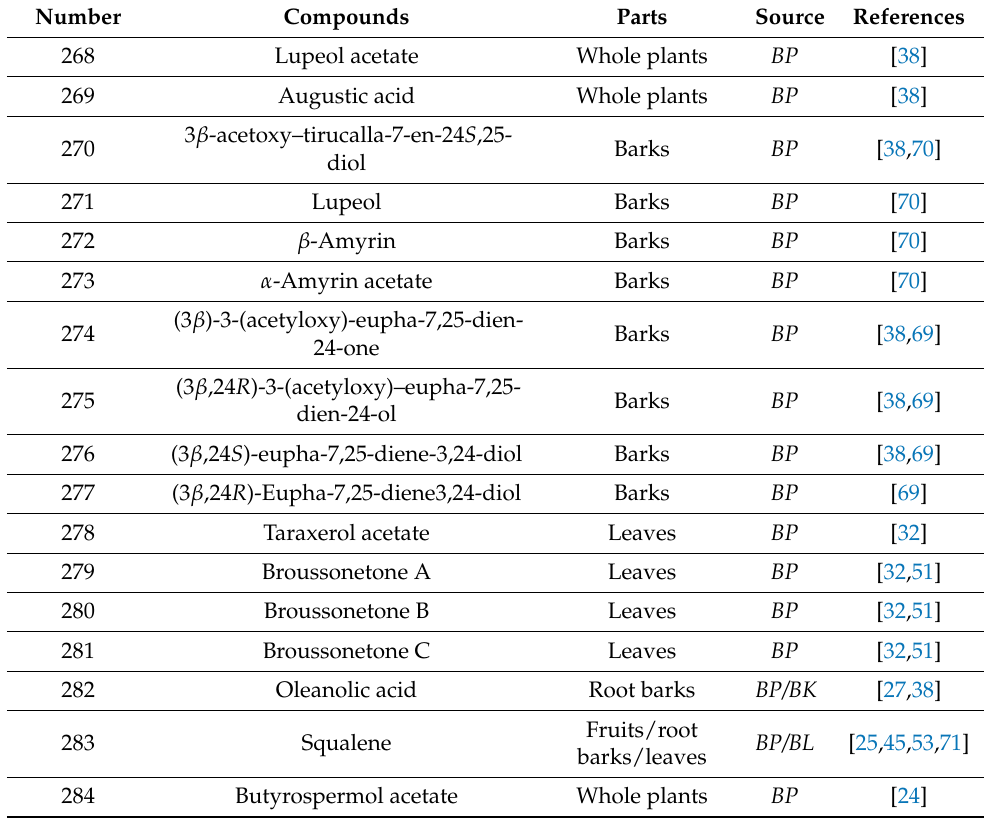
Table 5. Terpenoids isolated from Broussonetia